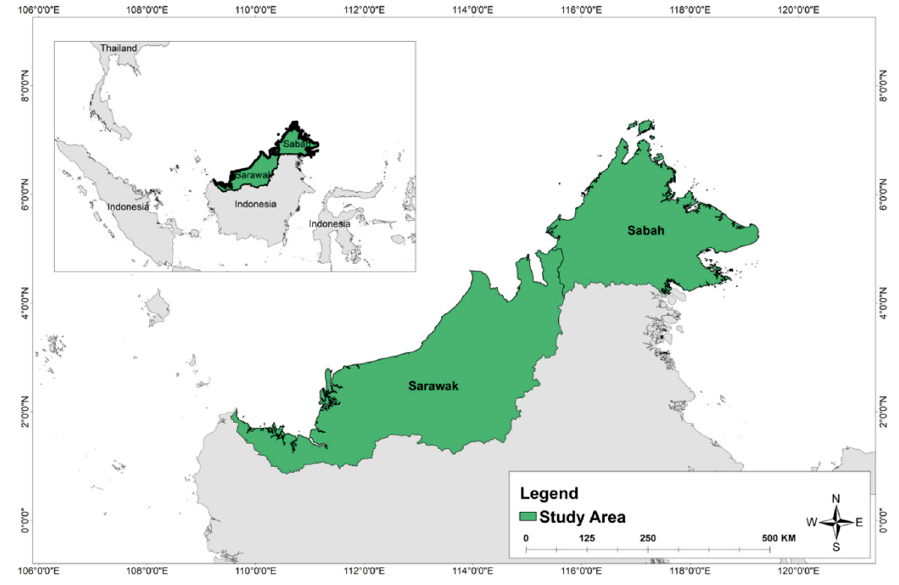
Figure 1. Study Area—Sarawak and Sabah states.